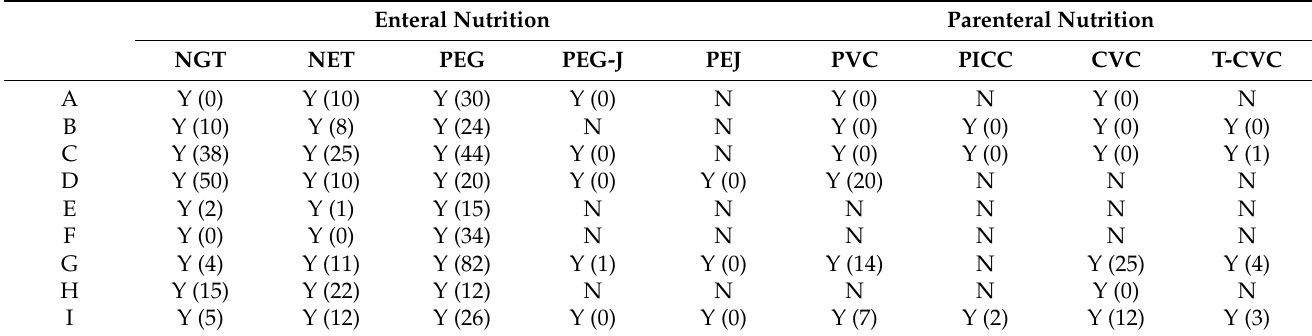
Table 2. Nutrition techniques by each department in 2018.